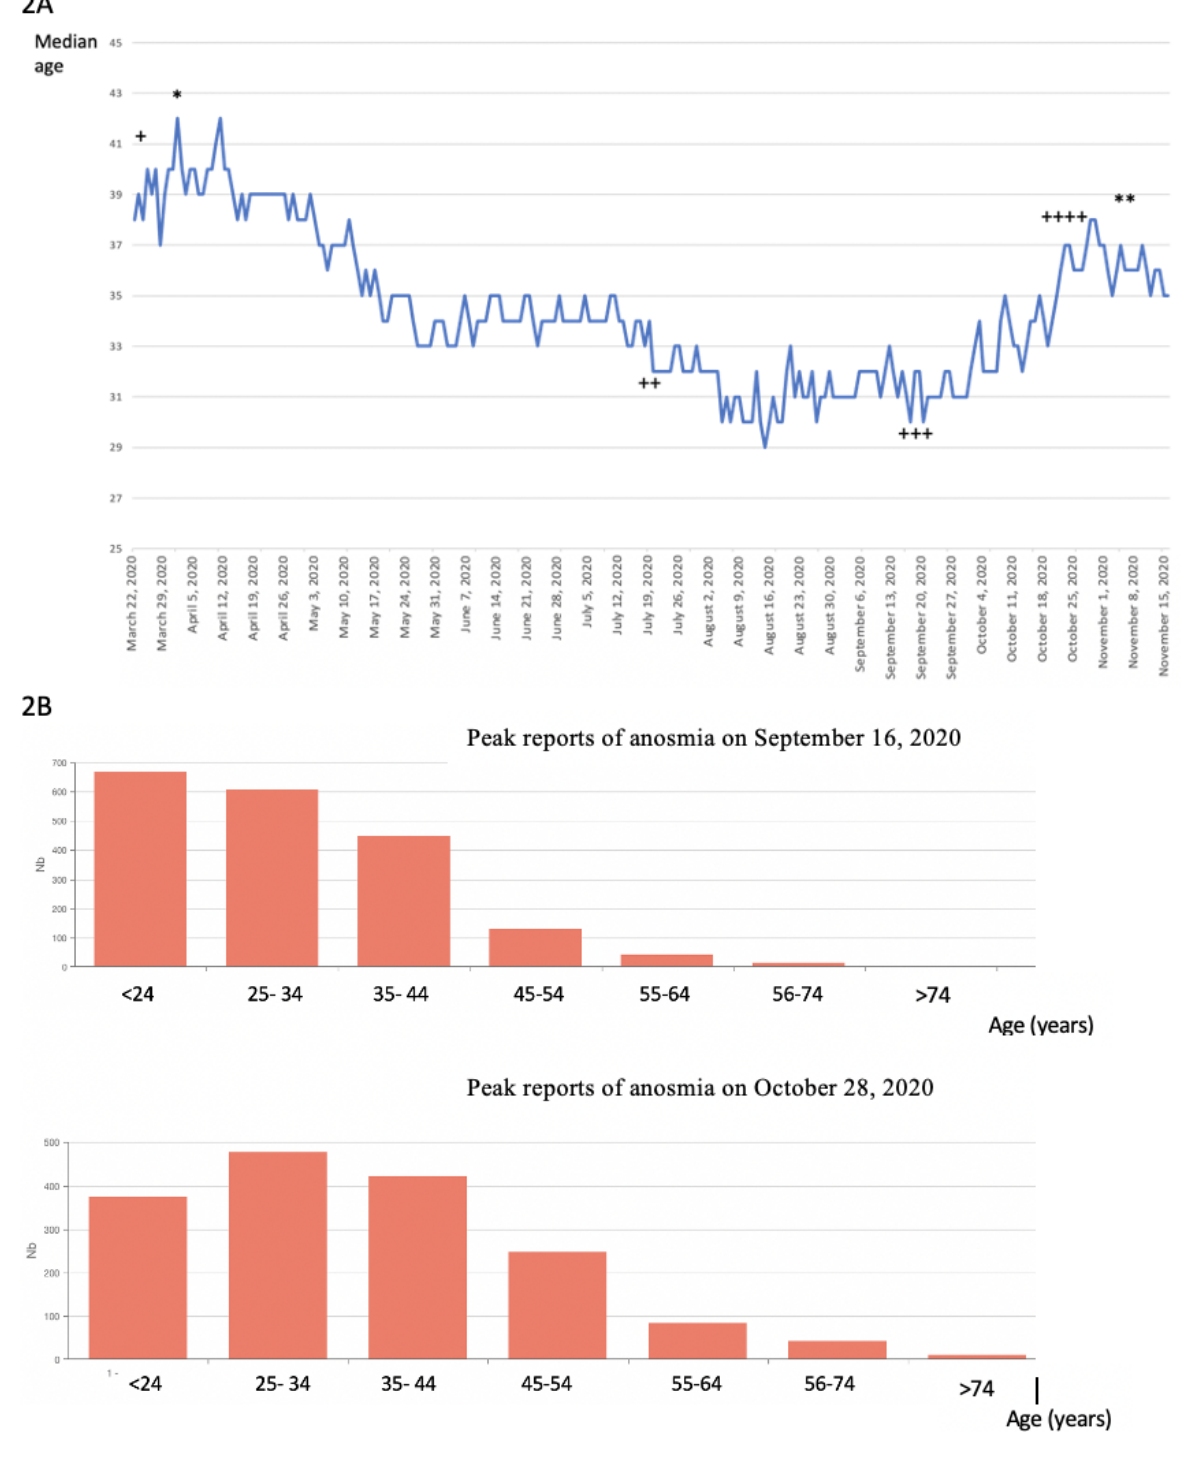
Figure 2. Age of users reporting anosmia on the web-based self-triage app maladiecoronavirus.fr during the COVID-19 outbreak in France. (2A) Median age of the users of the app. *Peak of hospitalizations during the first wave of the pandemic. **Peak of hospitalizations during the second wave of the pandemic. Four peaks of daily reports of anosmia were recorded from the web-based app: the first peak of reports of anosmia (+; median age=40 years), second peak of reports of anosmia (++; median age=32 years), third peak of reports of anosmia (+++; median age=30 years), and fourth peak of reports of anosmia (++++; median age=37 years). (2B) Histograms of the number of reports of anosmia based on the age of the users during third and fourth peaks of connections. Users of aged >45 years were more numerous in the October 2020 outbreak than in the September 2020 outbreak peak of during the second wave of hospitalizations (n=190/2088, 9.1% vs n=402/1668, 24.1%